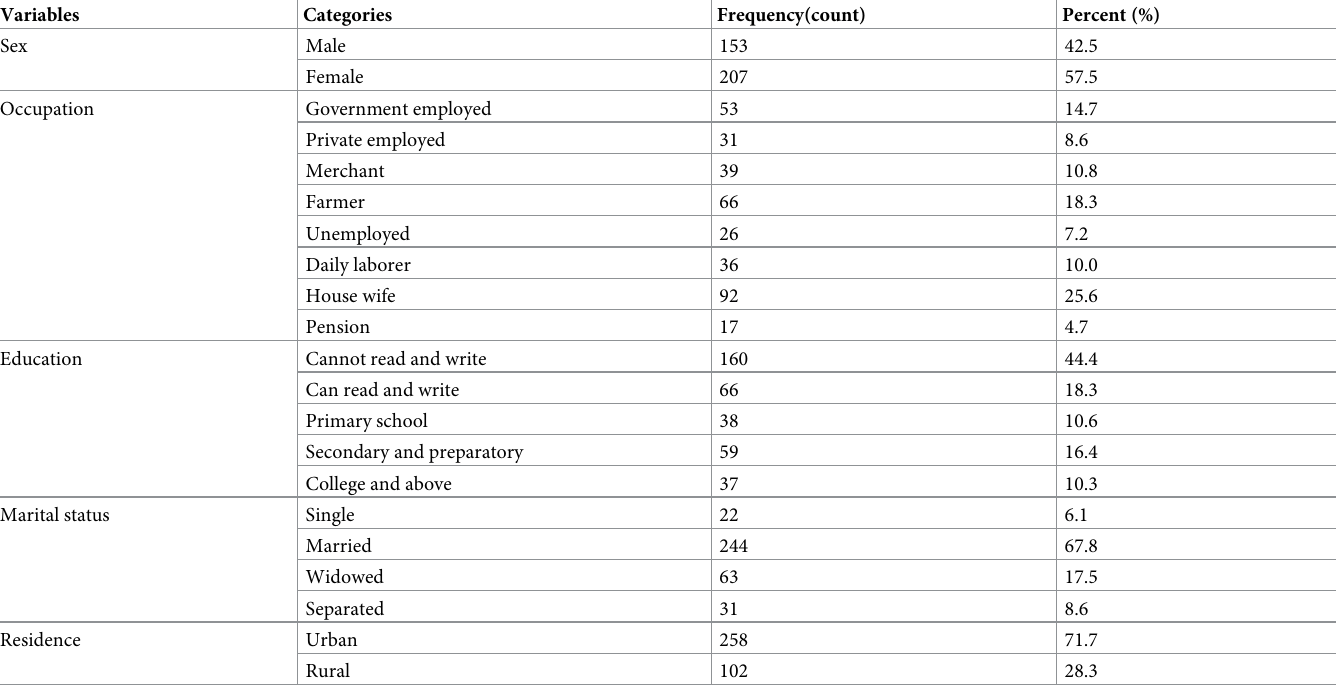
Table 1. Characteristics of hypertensive patients on treatment attending public health facilities in Dessie City Administration, Dessie, Northeast Ethiopia 2021 (360). Variables